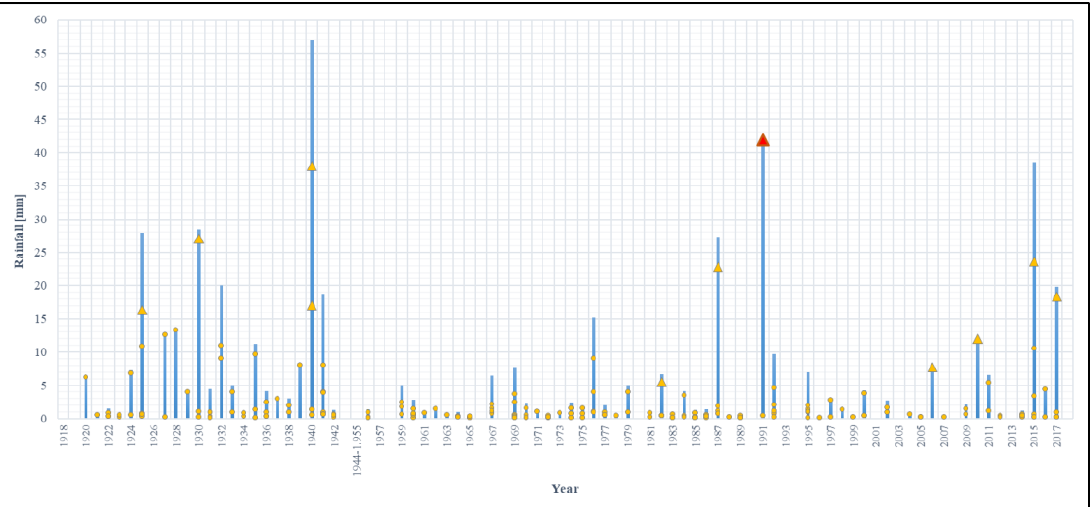
Figure 2. Record of annual (blue bar) and daily (yellow circles) rainfall between the years 1918–2018 of the city of Antofagasta. The yellow triangles indicate rainfall with flooding and/or development of flow-type landslides. The red triangle indicates the hydrometeorological of the flow-type landslide event which occurred in Antofagasta city on 18 June 1991. This event is considered the largest landslide disaster registered in Chile. Information source: [33,34]. Rainfall records from the Dirección Meteorológica de Chile (DMC).